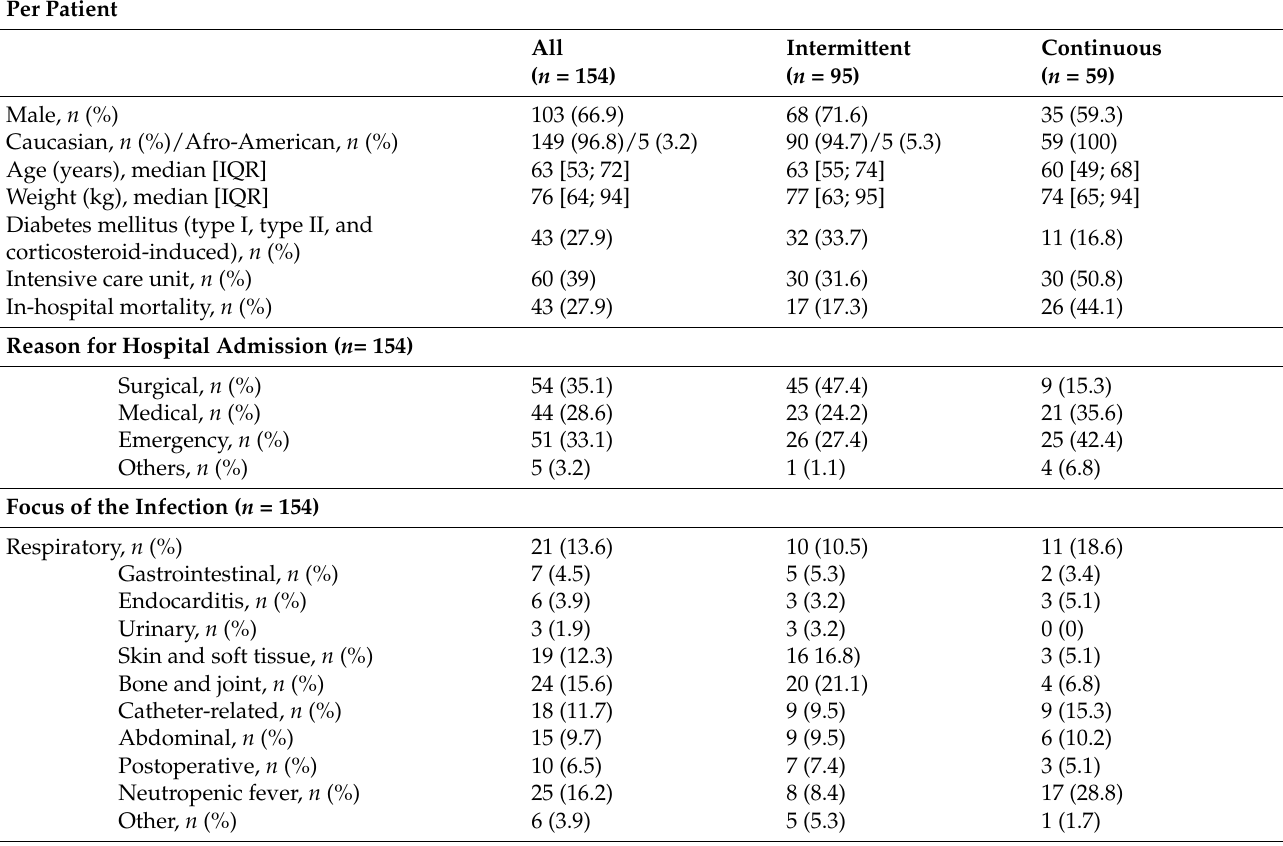
Table 1. Patient